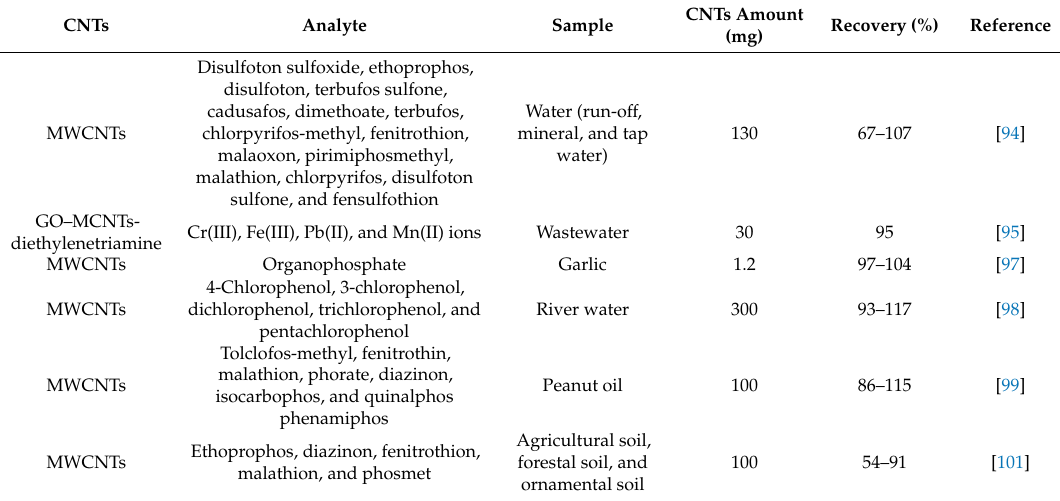
Table 4. The e ff ects of CNMs in the solid-phase extraction (SPE) technique.